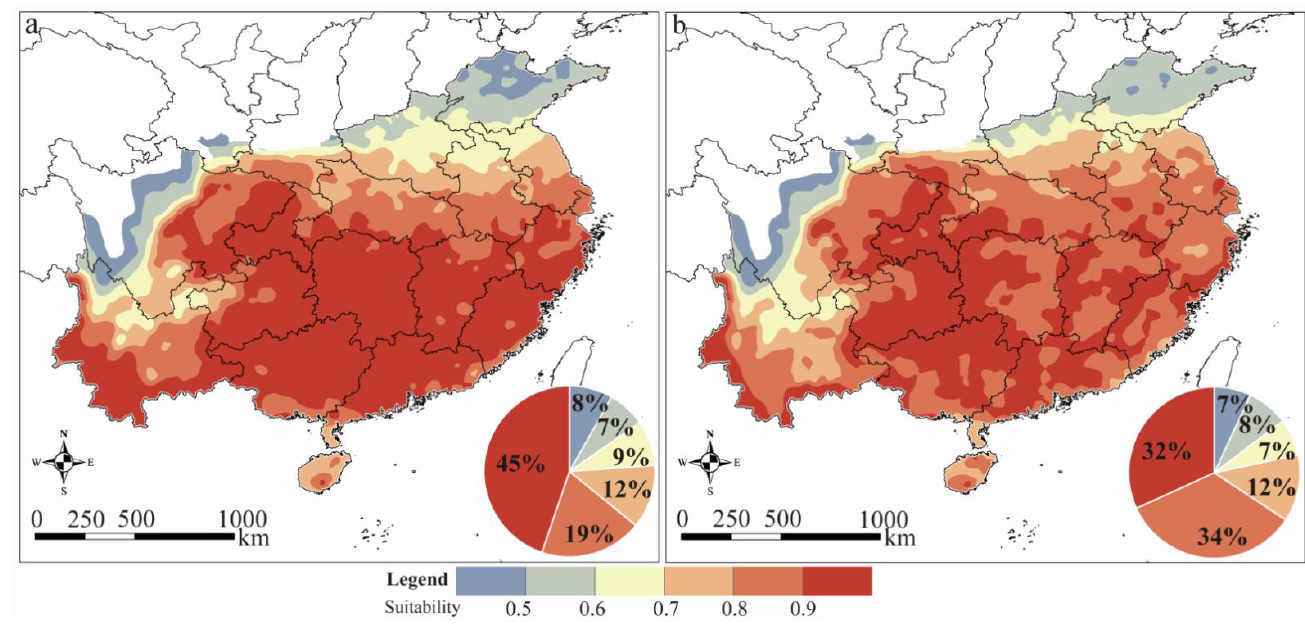
Figure 3. Tea Climate Suitability in mainland China in ( a ) 1987–1997 and ( b ) 2008–2017. The statistical percentage of each suitability with 0.1 range for whole tea planting areas in mainland China is displayed in the inset chart.